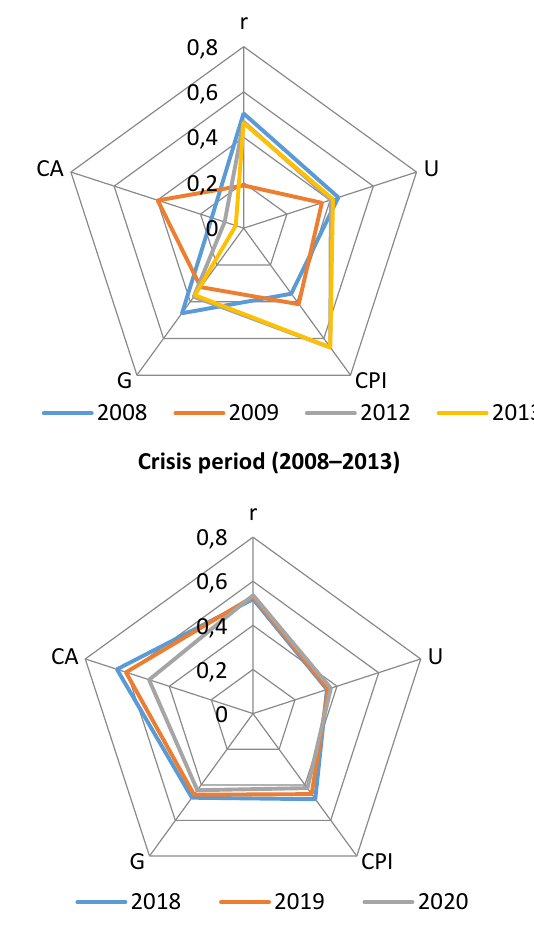
Source: Formed on the basis of authors